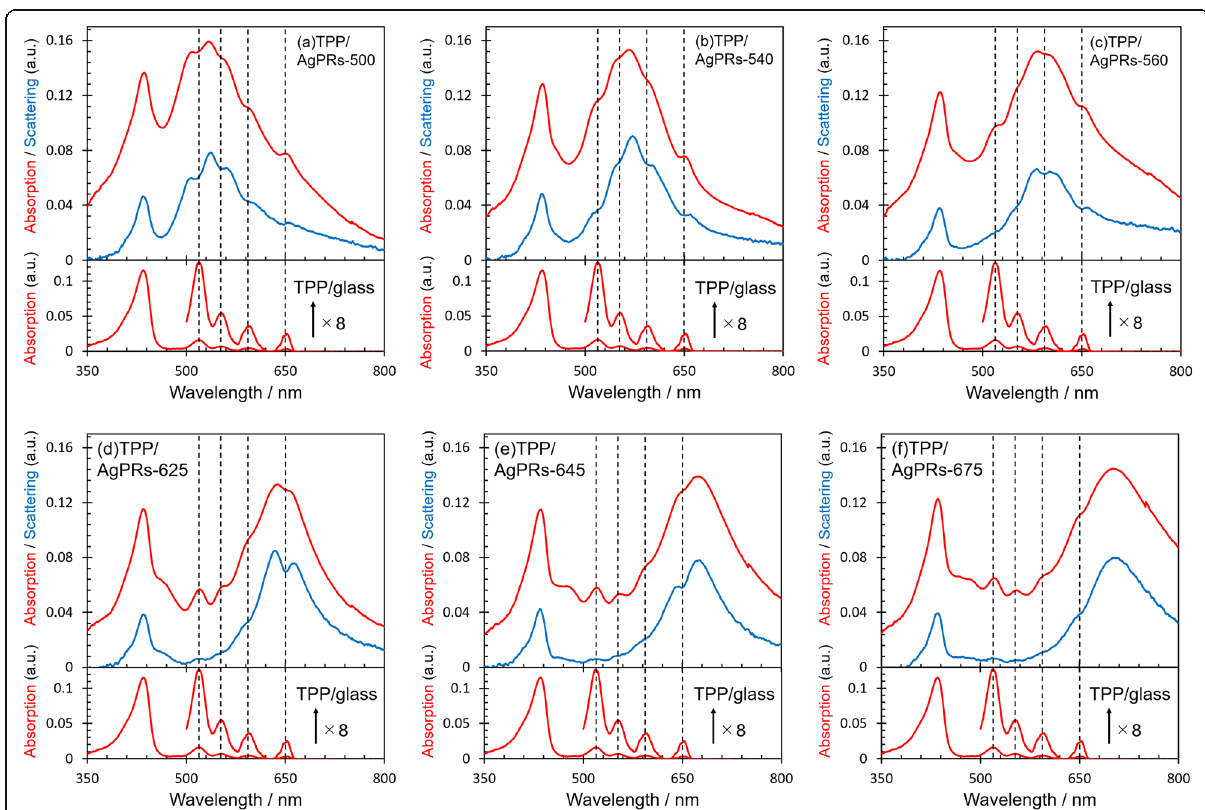
Fig. 4 Absorption (red line) and scattering (blue line) spectra. Dashed lines on the spectra represent absorption peak wavelengths of Q-bands of TPP/glass. a TPP/AgPRs-500. b TPP/AgPRs-540. c TPP/AgPRs-560. d TPP/AgPRs-625. e TPP/AgPRs-645. f